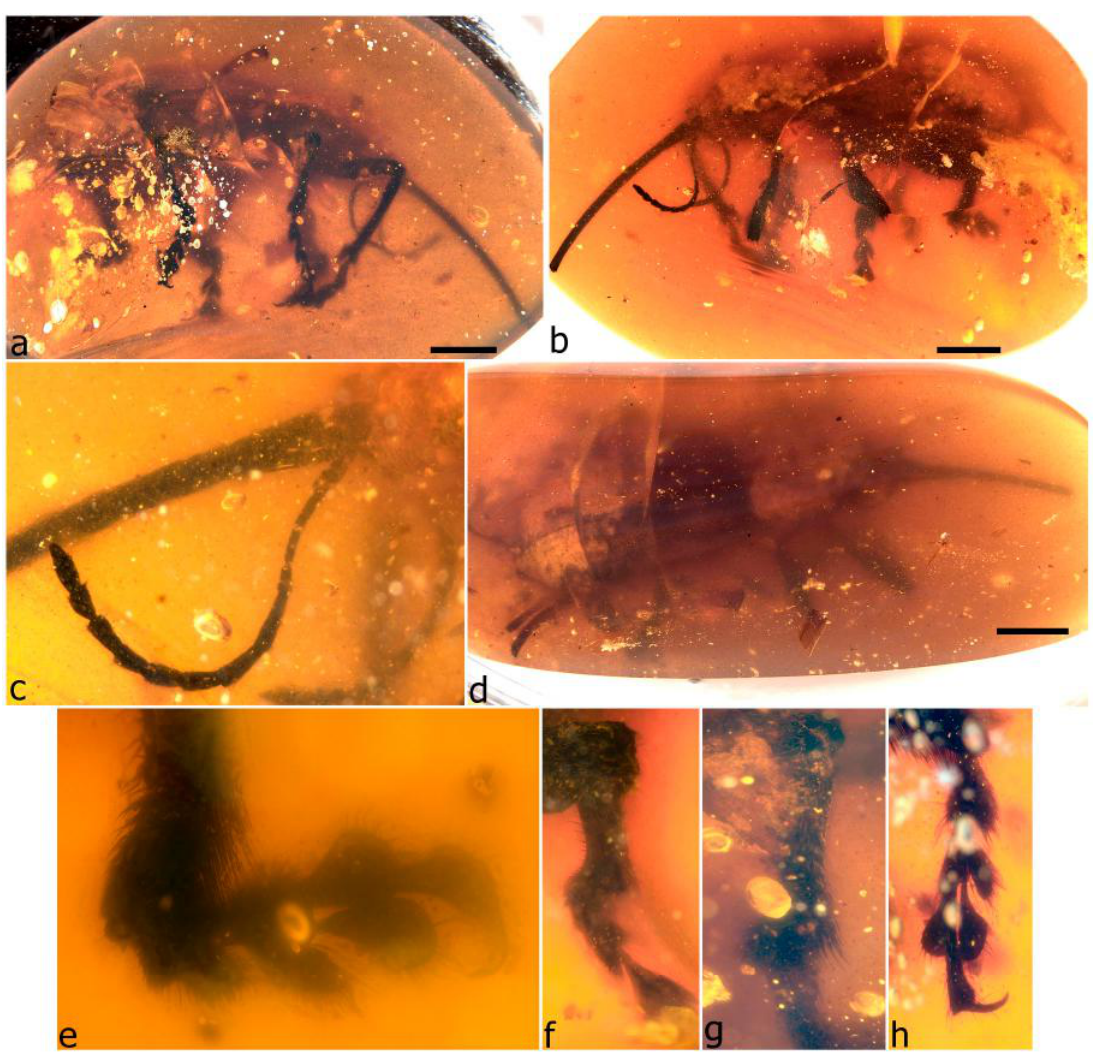
Figure 32. Cetionyx terebrans sp. n., holotype. Habitus, right lateral ( a ); left lateral ( b ); left antenna ( c ); habitus, dorsal ( d ); left metatarsus, dorsal ( e ); right mesotibia showing curvature ( f ); right mesotibia showing dorso-apical setal patch ( g ); right metatarsus, dorsal ( h ). Scale bars: 2.0 mm (a,b,d).